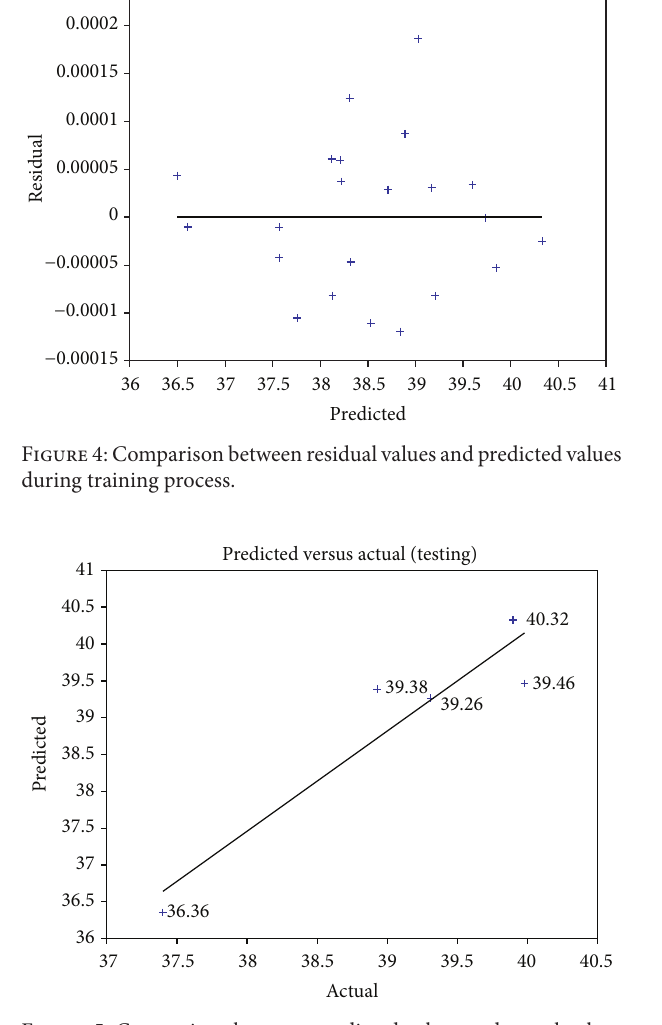
Figure 5: Comparison between predicted values and actual values during testing process.